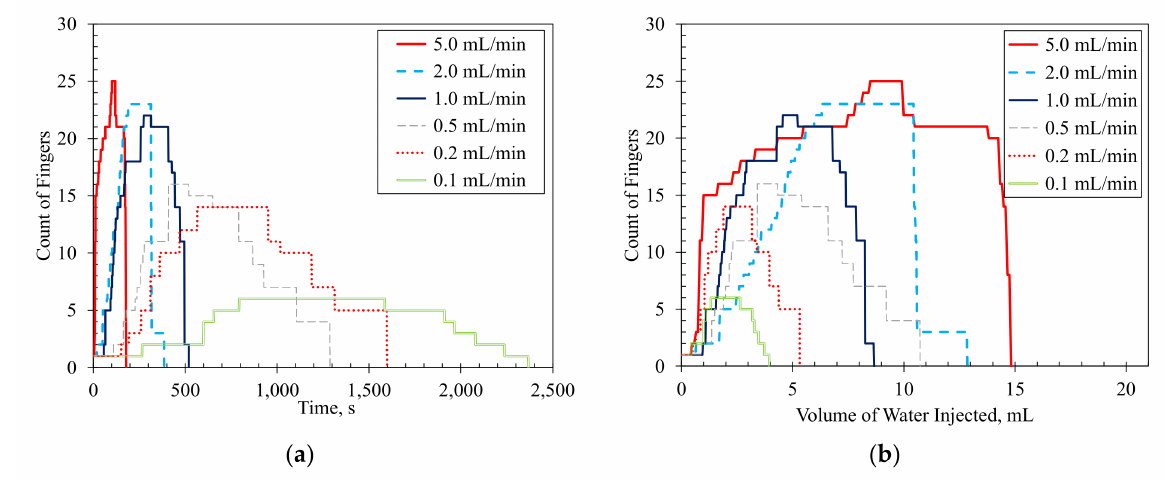
Figure 9. Count of fingers vs. time at different flow rates under constant pressure control at the outlet. ( a ) Count of fingers vs. time; ( b ) Count of fingers vs. volume of water